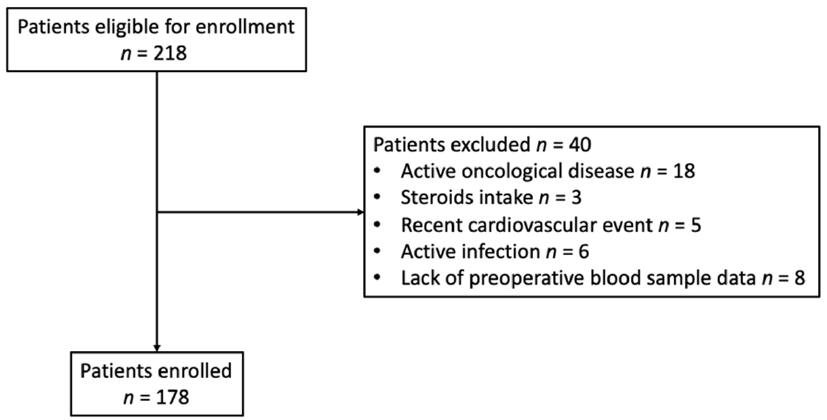
Figure 1. Flow diagram of study population enrollment.